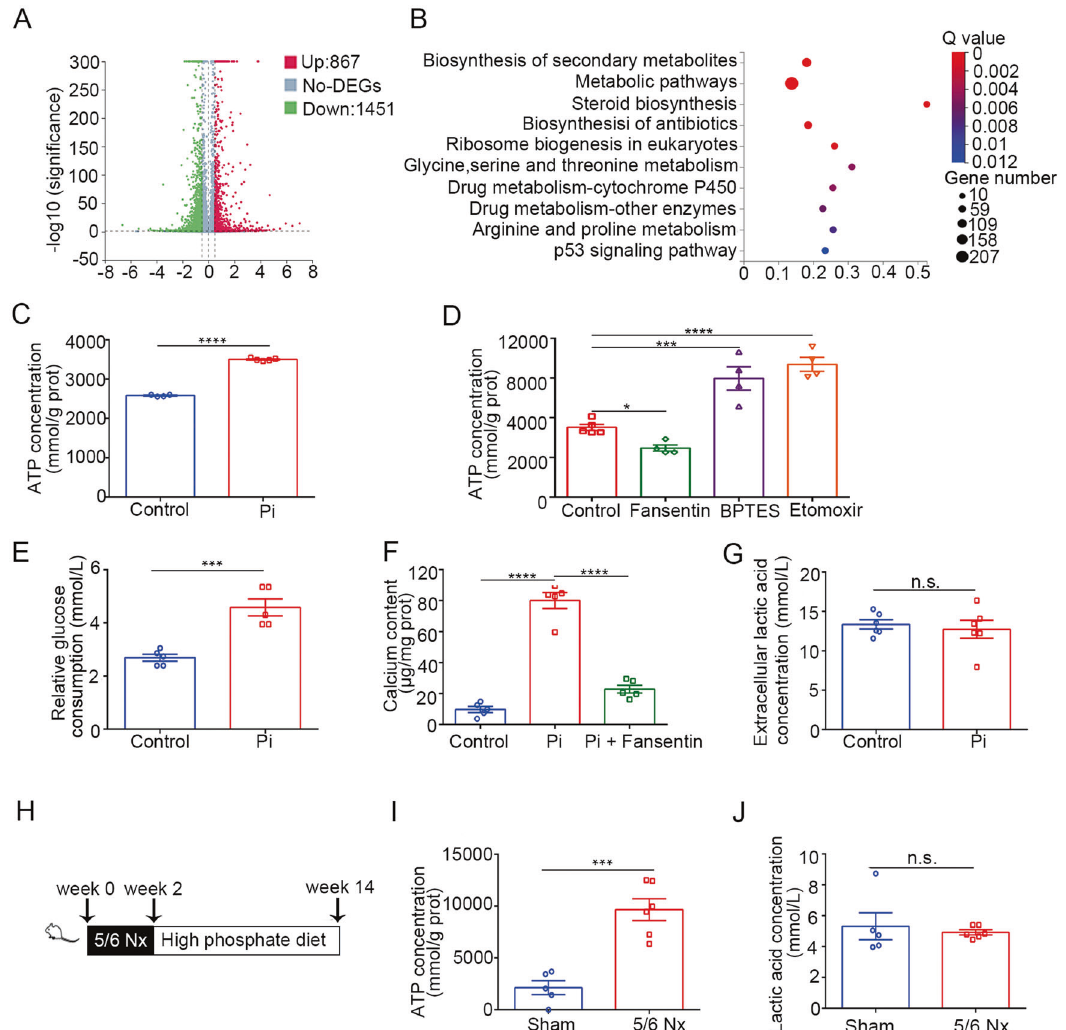
concentration of HASMC (unpaired t test; control n = 4, high phosphate n = 5). D ATP concentration of HASMC treated with high phosphate (one-way ANOVA; n = 4). E Relative glucose consumption of HASMC (unpaired t test; n = 5). F Calcium contents in HASMC (one-way